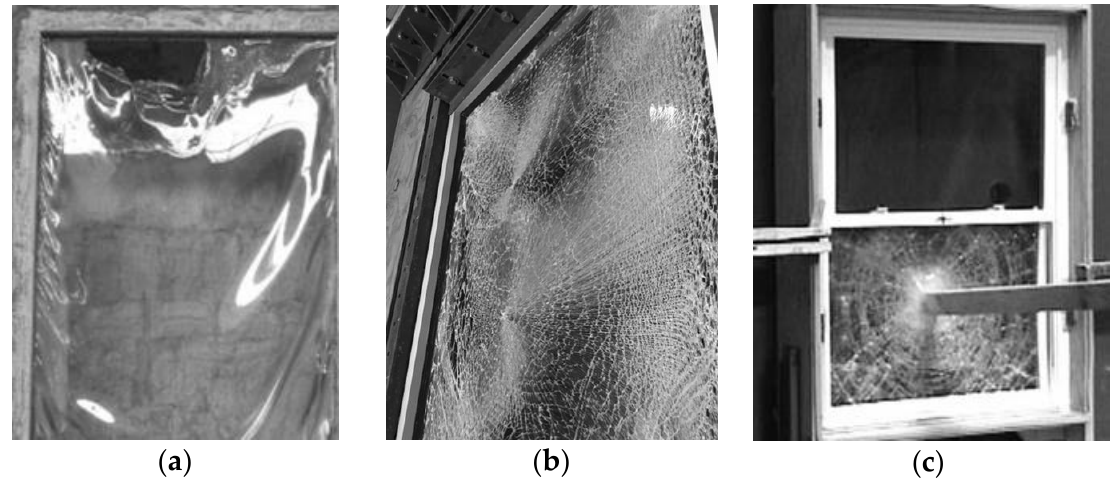
Figure 1. Examples of cracking and failure mechanisms in glass windows under ( a ) fire, ( b ) blast loading and ( c ) debris impact (photos reproduced and adapted from [7], CC BY 4.0, Copyright © 2017 Chiara Bedon).